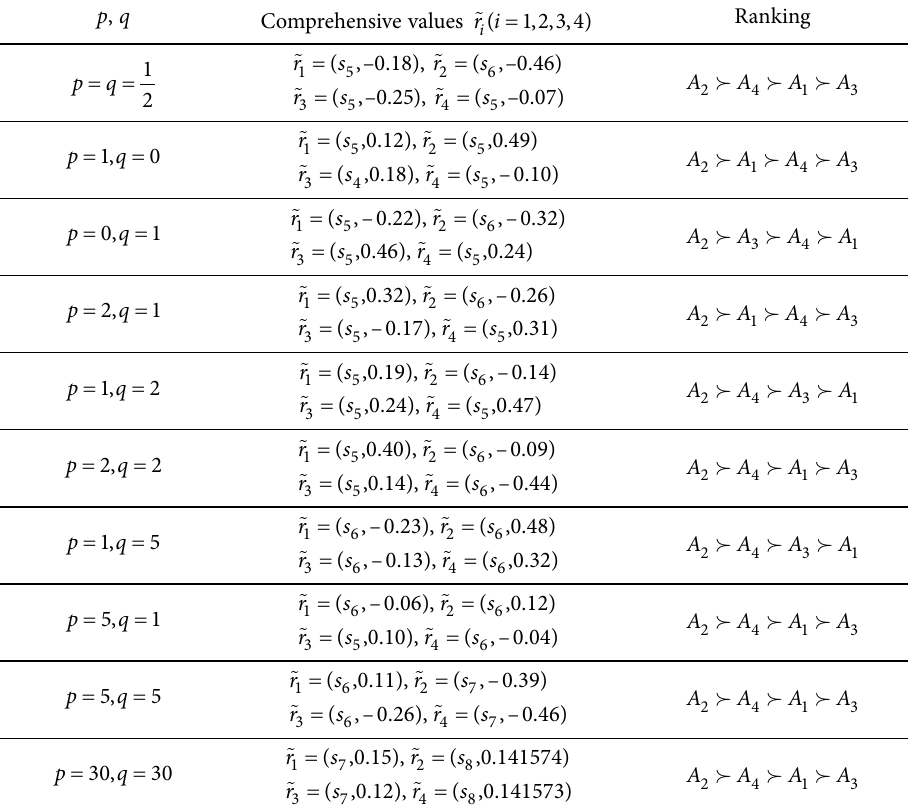
Table 7. Ordering of the alternatives by utilizing the different p , q in 2 TLWHM